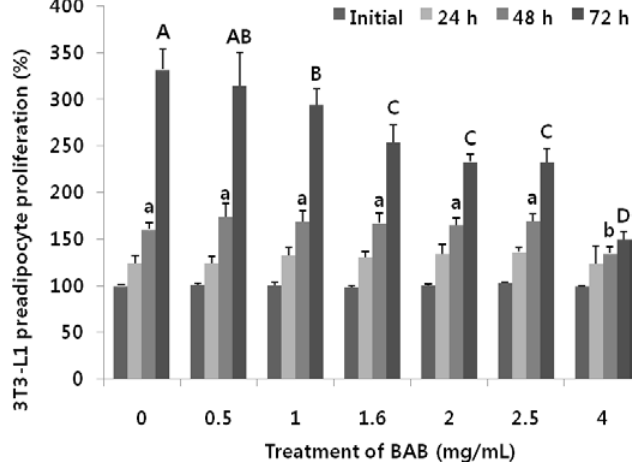
Figure 1. Effects of black adzuki bean on cell viability and preadipocyte proliferation rate of 3T3-L1. 3T3-L1 preadiocytes were exposed to different concentrations (0.5 to 4 mg/mL) of BAB extract for 24–72 h. Cell viability was measured by MTT assays and calculated as relative values vs. non-treatment controls (0 mg/mL) cells at the initial time point. Data are expressed as means ± SD and a different small letter (48 h) or capital mark letter (72 h) indicates a significant difference among groups, according to ANOVA with Duncan’s multiple range test ( p <